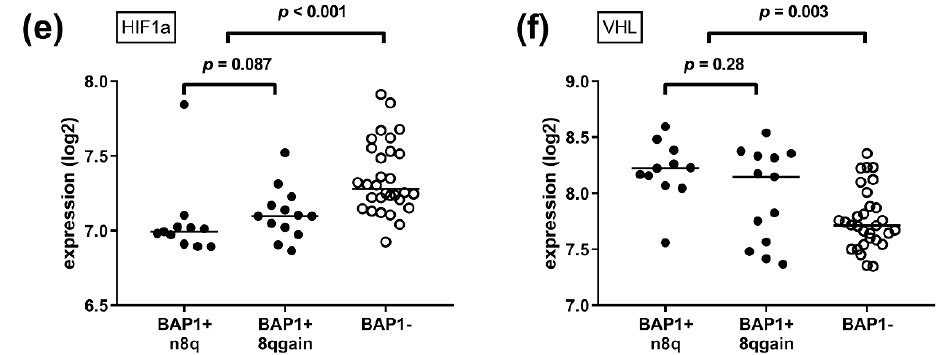
Figure 2. Tumour genetics in relation to MVD and mRNA gene expression. Gain of chromosome 8q is an early event in UM development, while loss of BAP1 is a later event. ( a ) IHC counts of MVD ( n = 43), ( b ) mRNA gene expression of CD68 macrophages ( n = 54), ( c ) mRNA gene expression of VEGF-A ( n = 54), ( d ) mRNA gene expression of VEGF-B ( n = 54), ( e ) mRNA gene expression of HIF1a ( n = 54), and ( f ) mRNA gene expression of VHL ( n = 54). ( p -values were obtained using Mann–Whitney U tests, comparing BAP1+ and n8q with BAP1+ and 8qgain patients, and all BAP1+ with all BAP1 − patients. Abbreviations: BAP1+, BAP1-positive; BAP1 − , BAP1-negative; n8q, normal chromosome 8q; 8qgain, gain of chromosome 8q).